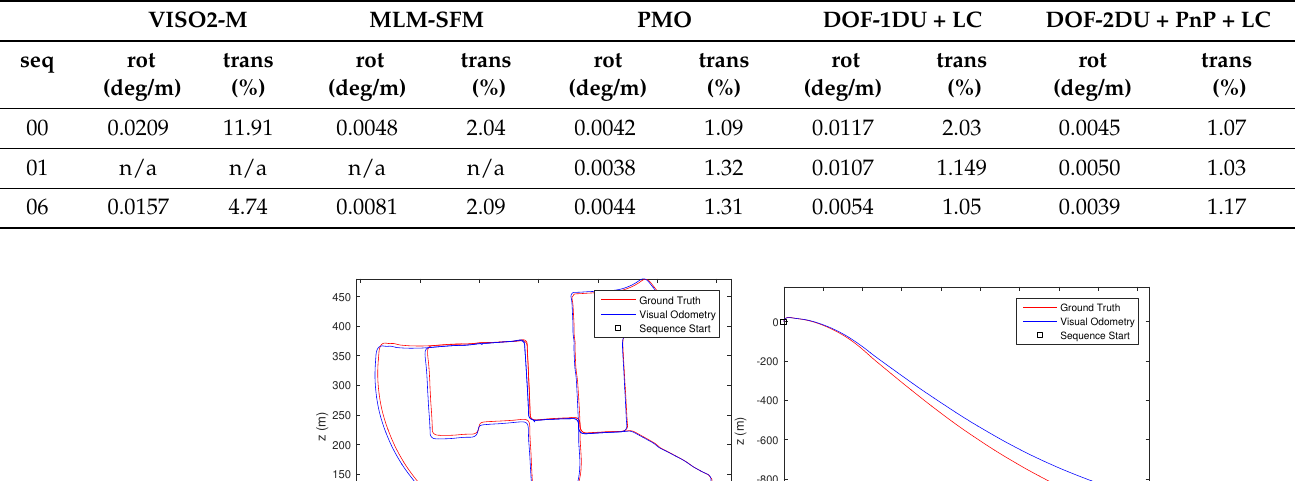
Table 2. Comparison of visual odometry accuracy for VISO2-M [22], MLM-SFM [10], PMO [11], dense optical flow with 1D uncertainty and loop closure (DOF-1DU+LC) [36], and our new proposed methods (DOF-2DU+PnP+LC) for selected KITTI dataset.